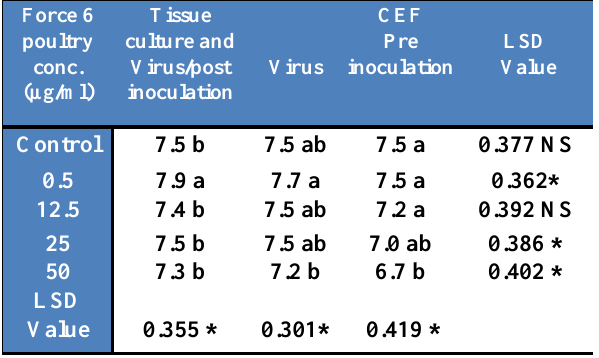
Table, 1: Effect of force 6 poultry (conc.) in Log of IBDV on Tissue Culture and Virus – Virus – Tissue Culture. (TCID50 Titer).